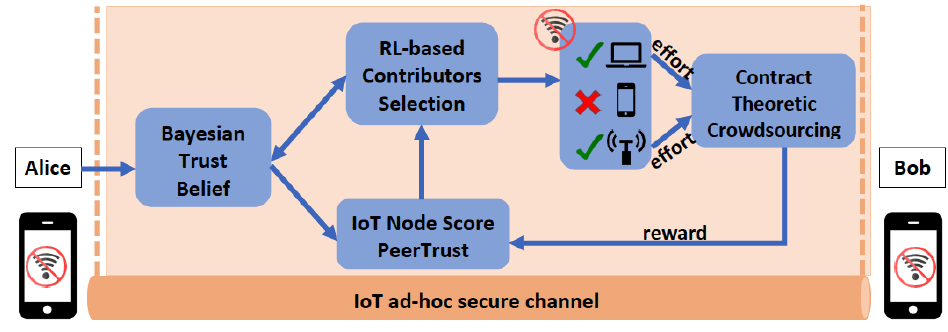
Figure 1. General